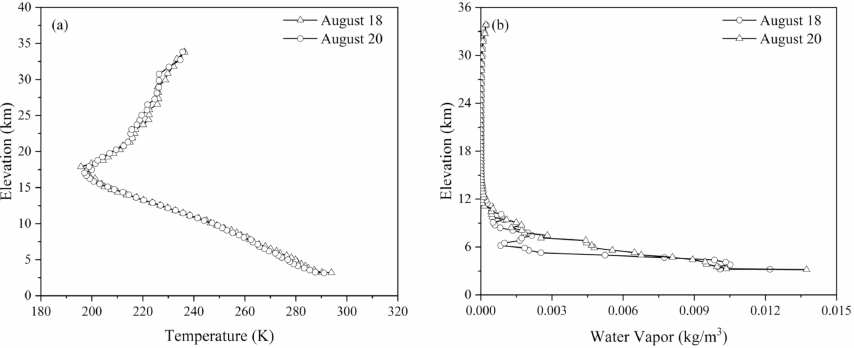
Figure 6. The atmospheric profiles. ( a ): the atmospheric temperature and ( b ): the water vapor content measured by the radiosonde